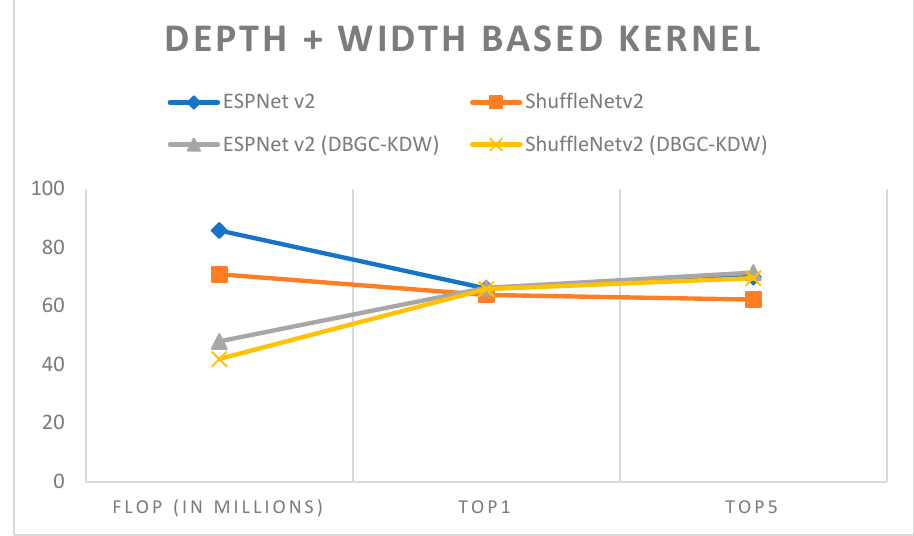
Figure 19. Depth+width-based kernel. Figure 19. Depth + width-based